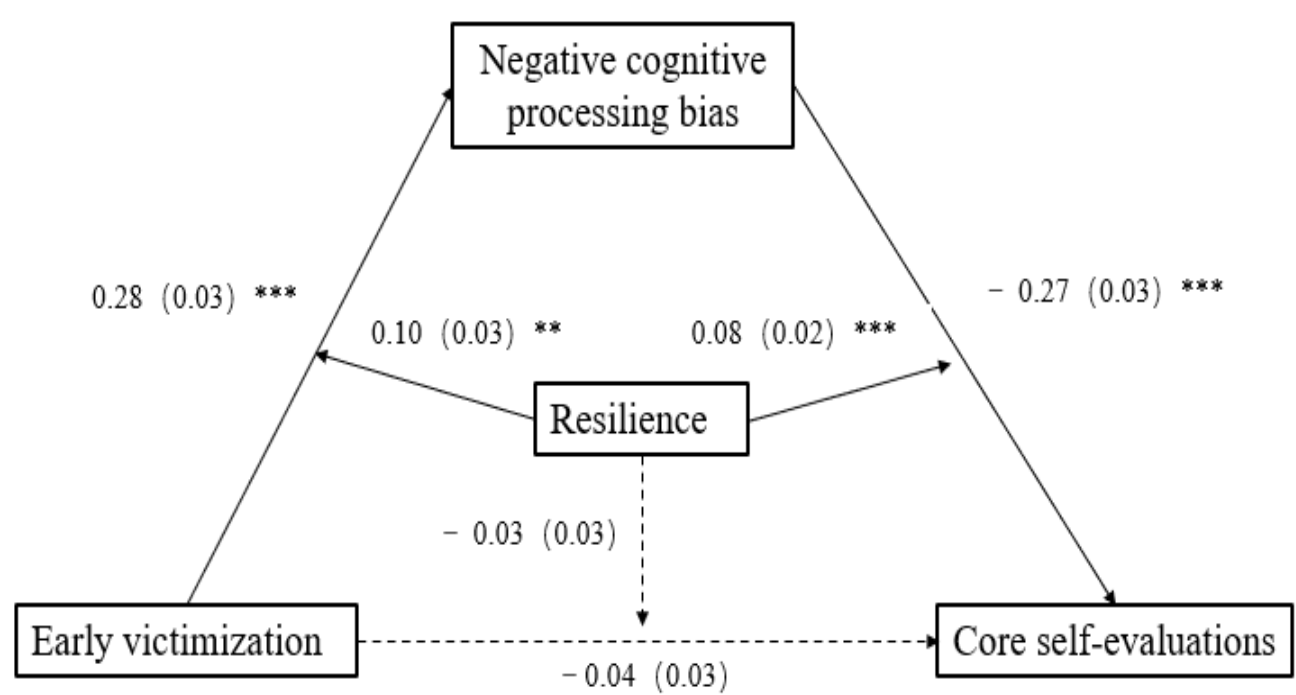
Figure 2. The moderated mediation model. Negative cognitive processing bias completely mediated the relationship between early victimization and core self-evaluation. Resilience moderated the first and second parts of the mediation process. Path values are the path coefficients (standard errors). (The dotted line indicates that p is greater than 0.05). *** p < 0.001. ** p < 0.01.